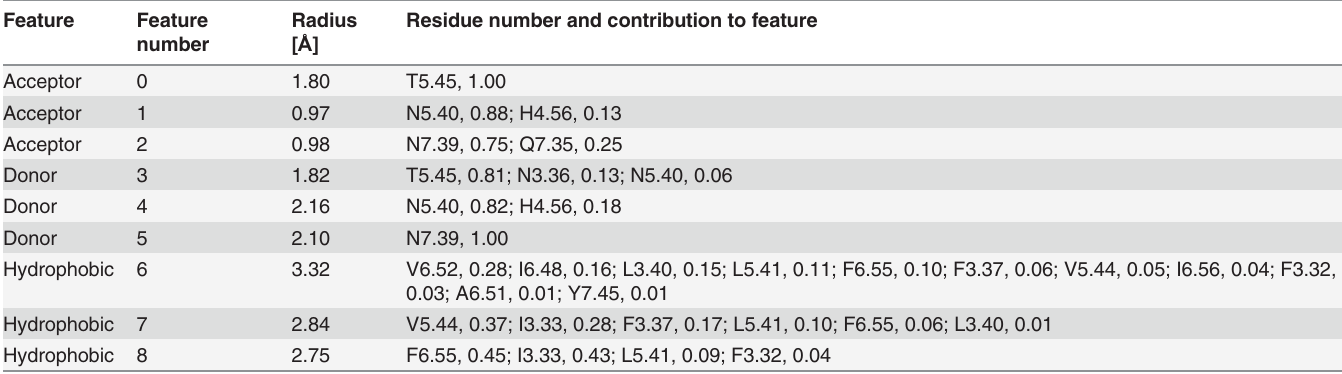
Table 1. Snooker pharmacophore features. Feature type, feature number, radius and residue contributions by amino acid number.